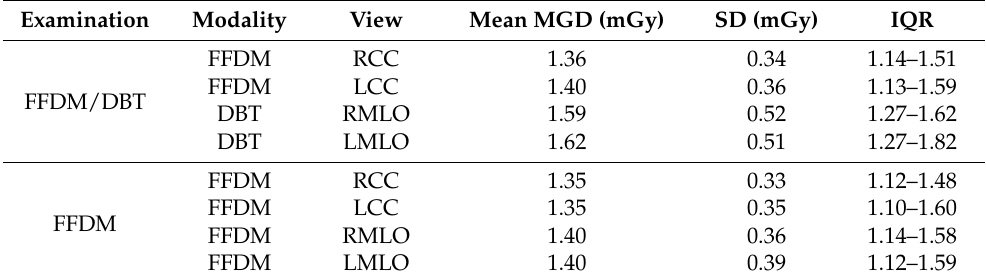
Table 2. Mean average glandular dose (MGD), standard deviation (SD), and interquartile range (IQR) per each view and modality.